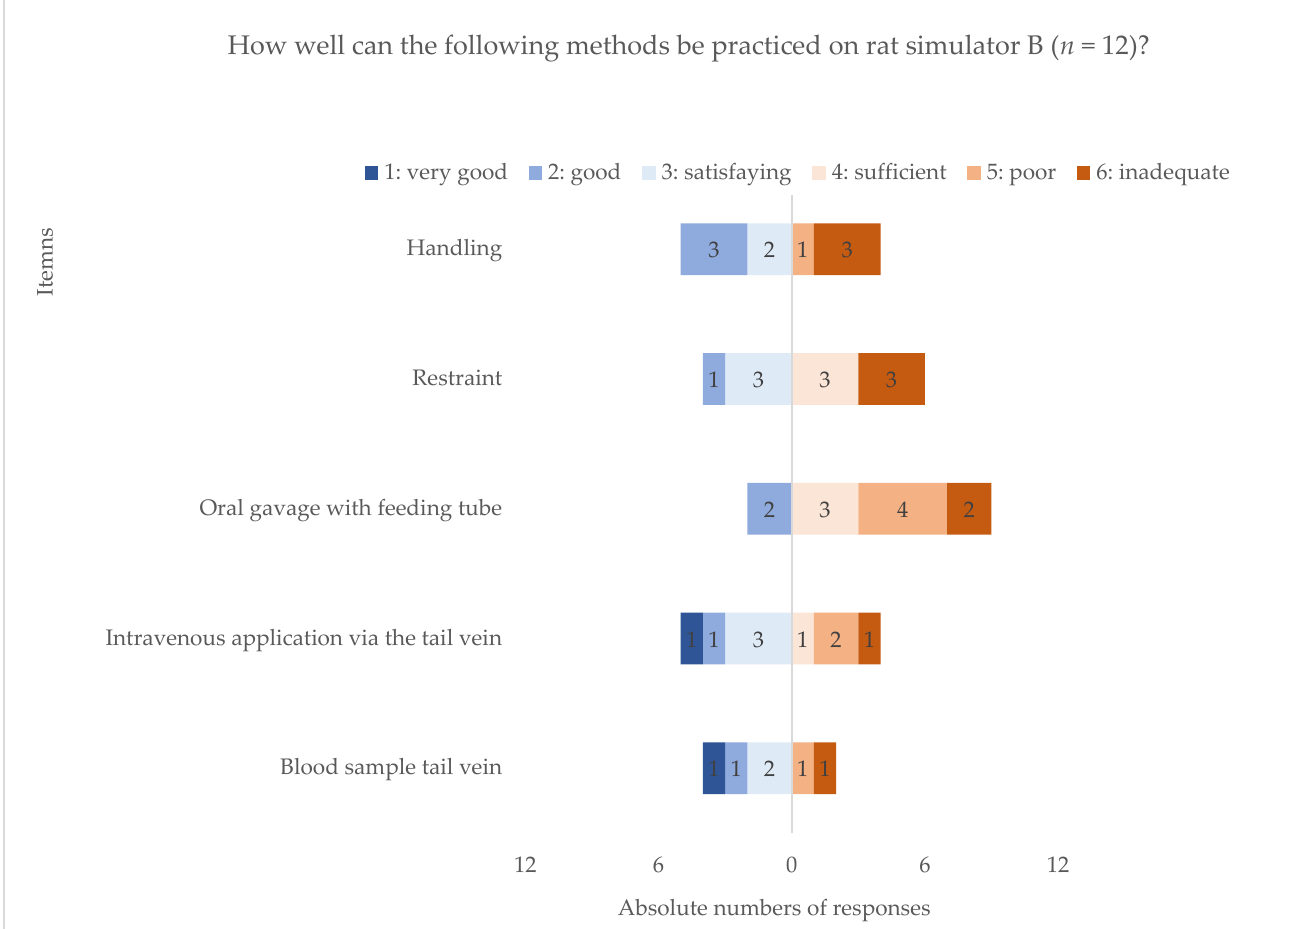
Figure 3. Descriptive analysis of methodical satisfaction with rat simulator type B. Distribution of replies on how well certain handling techniques can be practiced on rat simulator type B on a six-point Likert scale, referring to the most frequently performed course type. Data are shown in a diverging stacked bar chart. Handling and procedural techniques are listed on the y-axis, response frequencies on the x-axis, ranging from “1: very good” (dark blue), “2: good” (blue), “3: satisfactory” (light blue) on left- to “4: sufficient” (light red), “5: poor” (red), “6: inadequate” (dark red) on the right-handed diverging stacked bars. Absolute number of responses is shown for each technique in the corresponding bar ( n = 12).